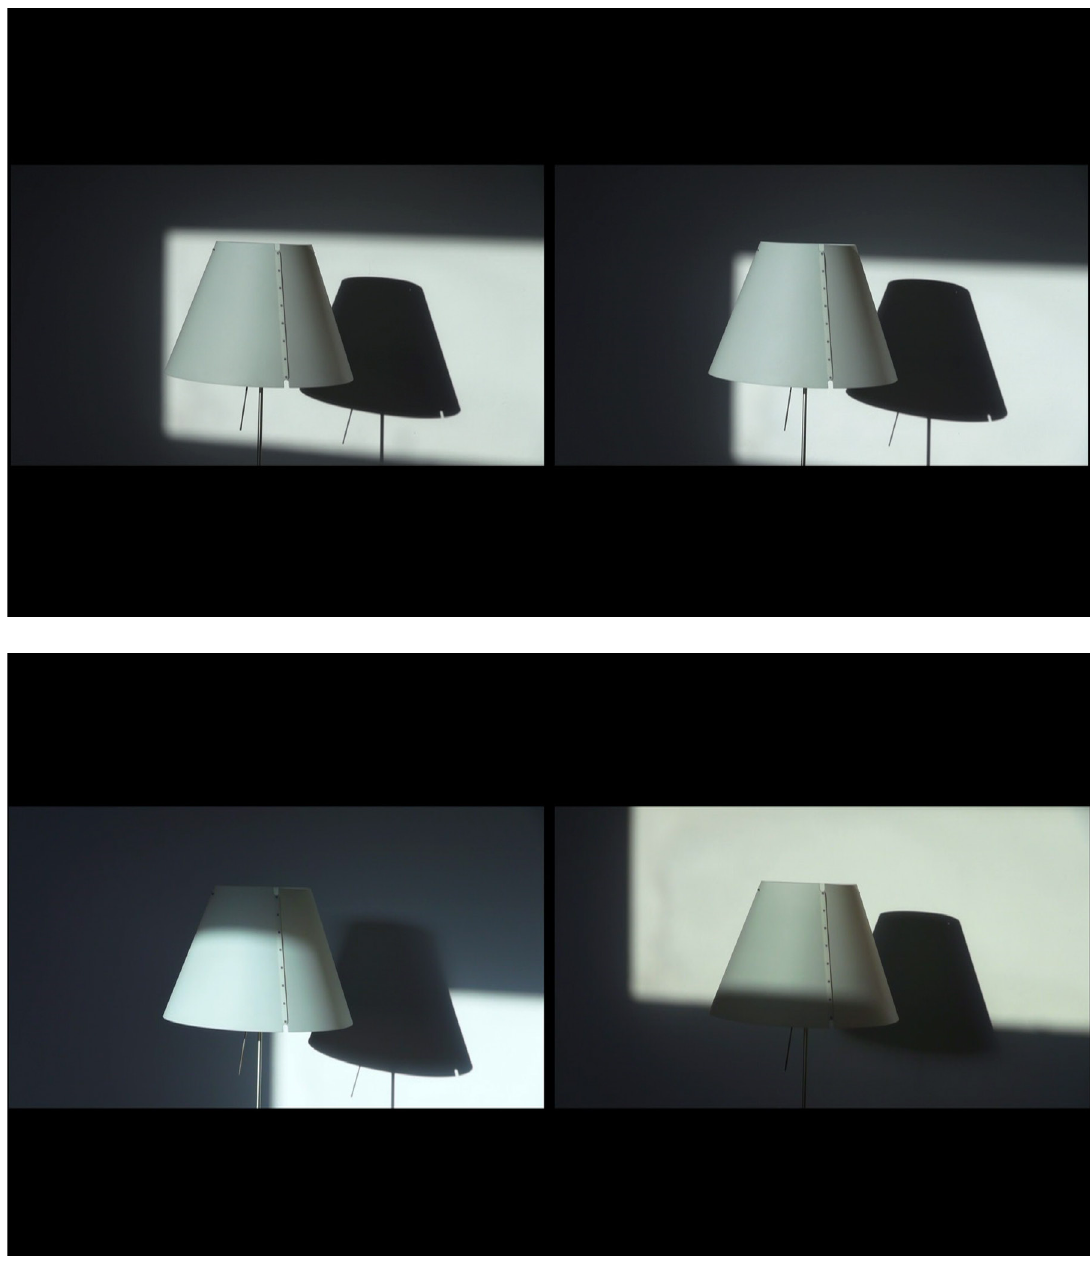
Figs. 5 and 6 Roos Theuws, the Same Sun, two-channel video installation, 2017 In The Same Sun (2017) on a 27inch I-mac, two images are shown. The left screen shows the effect of the rising of the sun through a window, which enlightens a lamp that casts a shadow through the light that falls on it. The right screen shows the same film in reverse. At a certain point, they coincide and time seems to stand still, as if time did not develop as a linear program but created a still point of the turning world. The power supply is provided by solar panels, fed by the same sun as the camera was making use of when shooting the imagery. Physically, the solar panels darken the space, because they are installed in front of the